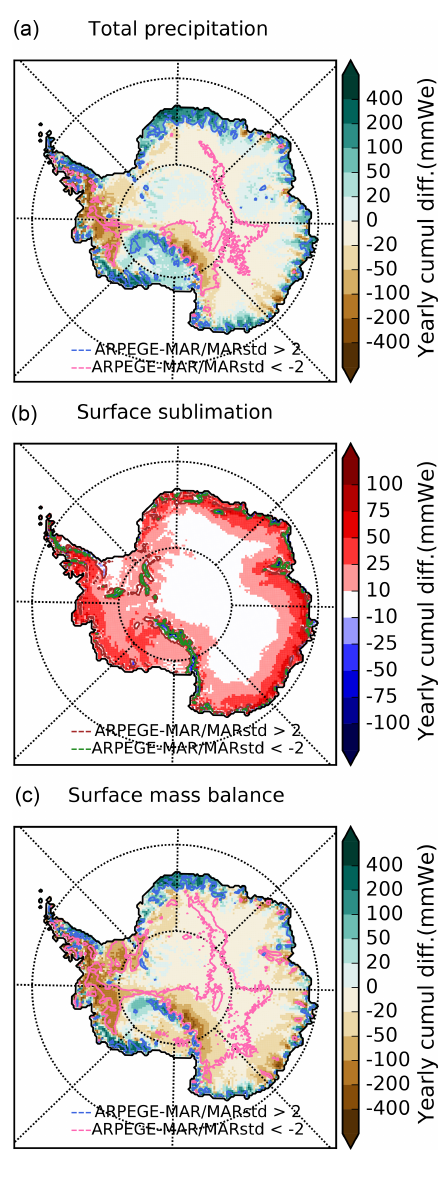
Figure 5. Total precipitation (a) , sublimation/evaporation (b) and SMB (c) for the ARP-AMIP minus MAR–ERA-I difference (mmw.e.yr − 1 ) for the reference period 1981–2010. Pink (brown) and blue (green) contour lines represent areas where ARPEGE- MAR absolute differences are respectively larger than 2 MAR stan- dard deviations of the annual mean (2 σ